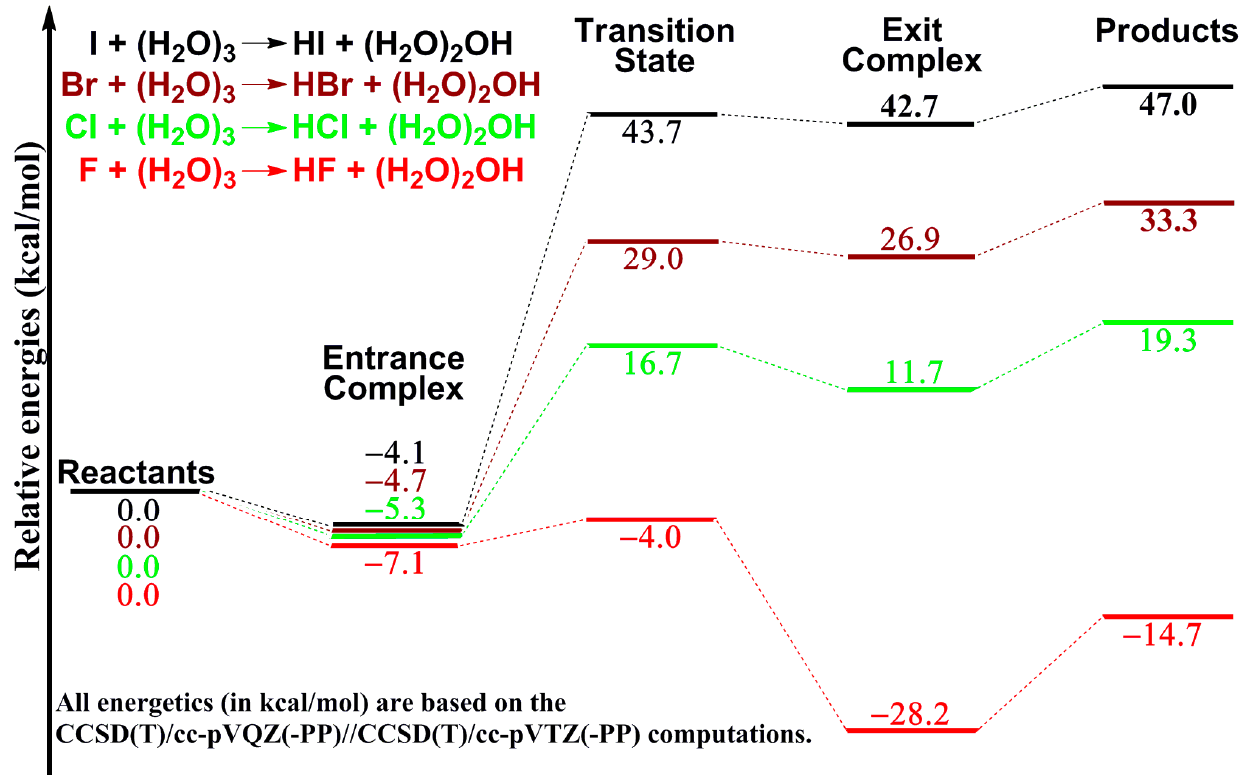
Figure 3. Comparison of the potential energy profiles for the I + (H 2 O) 3 (black), Br + (H 2 O) 3 (brown), Cl + (H 2 O) 3 (green) and F + (H 2 O) 3 (red) reactions. The PP is only used for the bromine and iodine atoms.